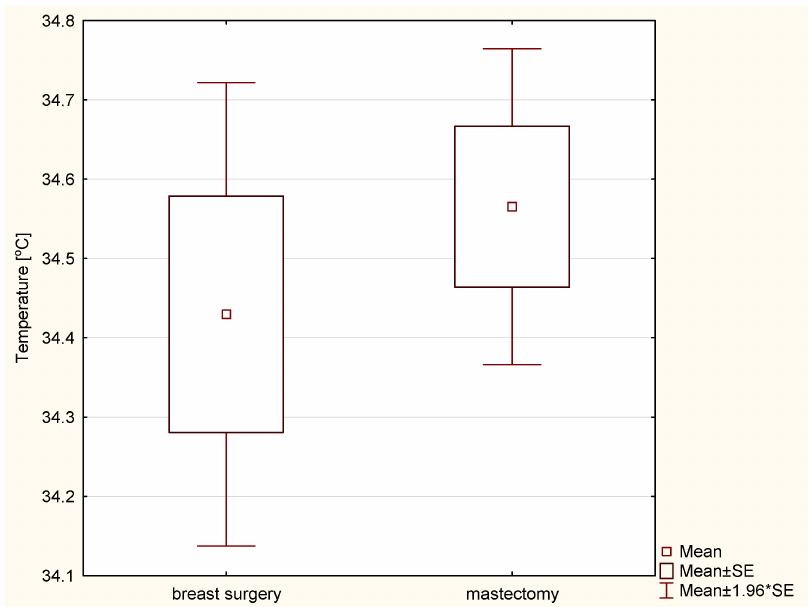
Figure 5. Average temperature of patients after breast conserving surgery and mastectomy in the PTV area after 3 weeks of radiotherapy.